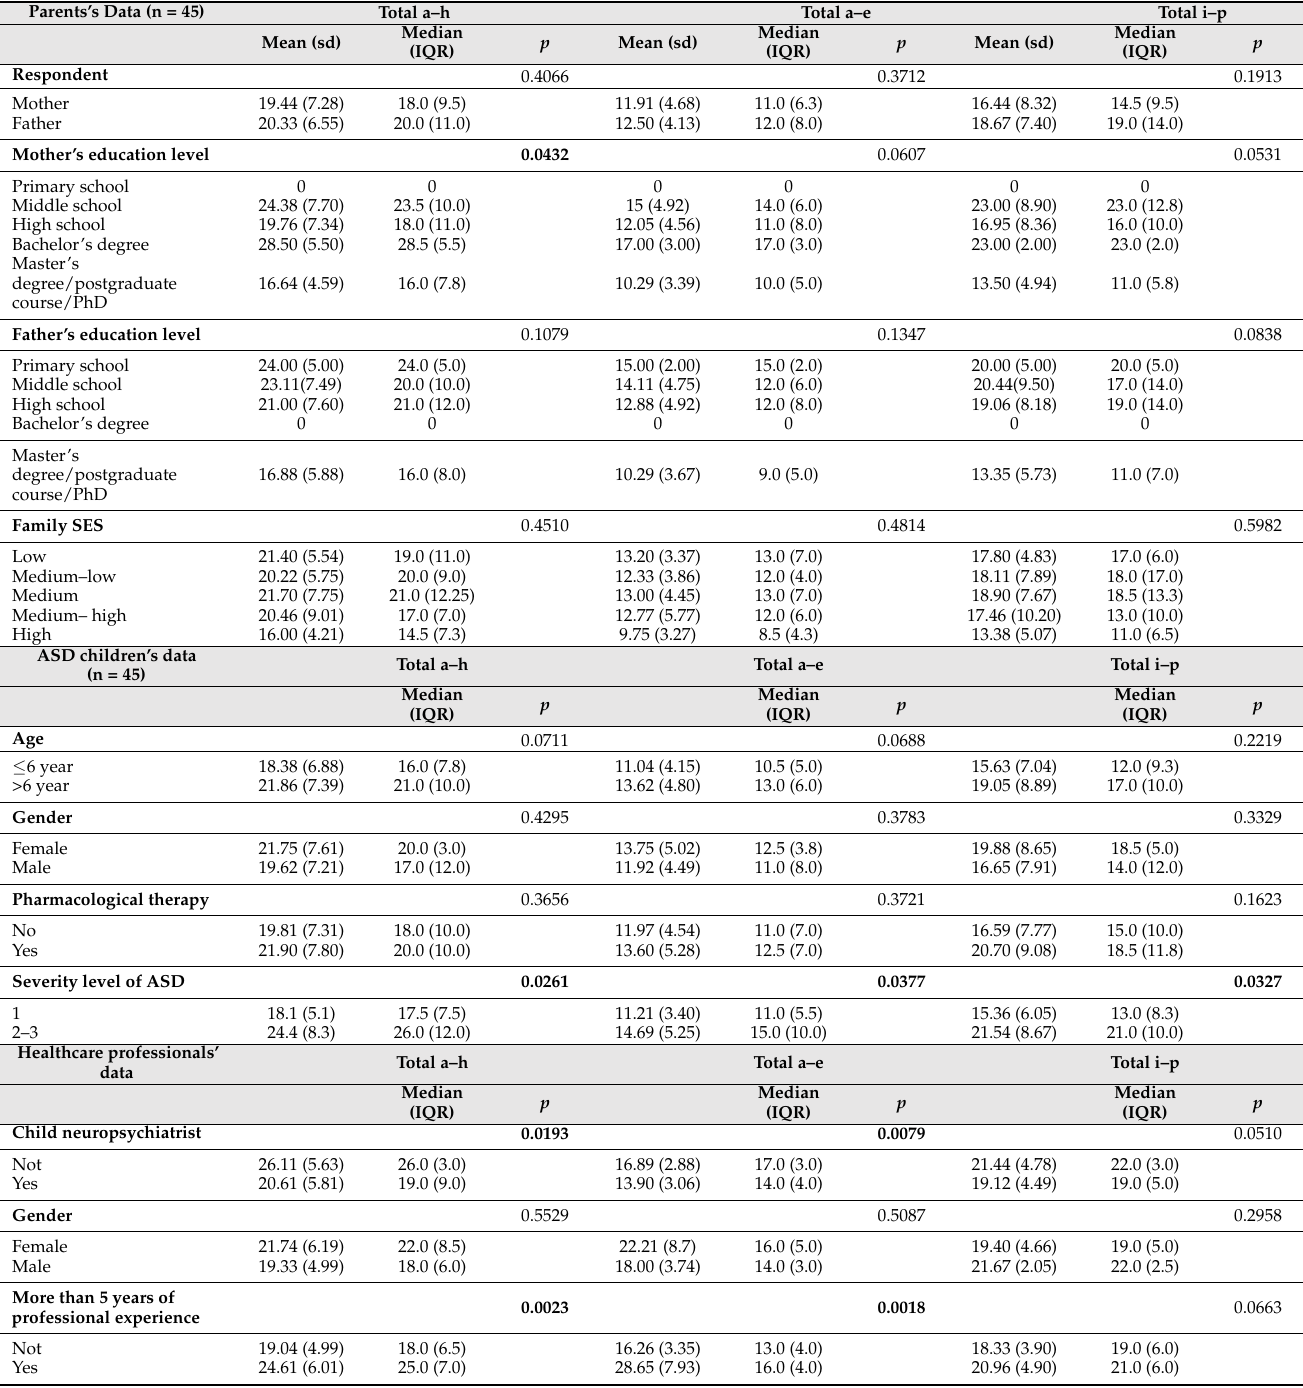
Table 3. Comparison of respondents’ answers using Wilcoxon Rank Sum